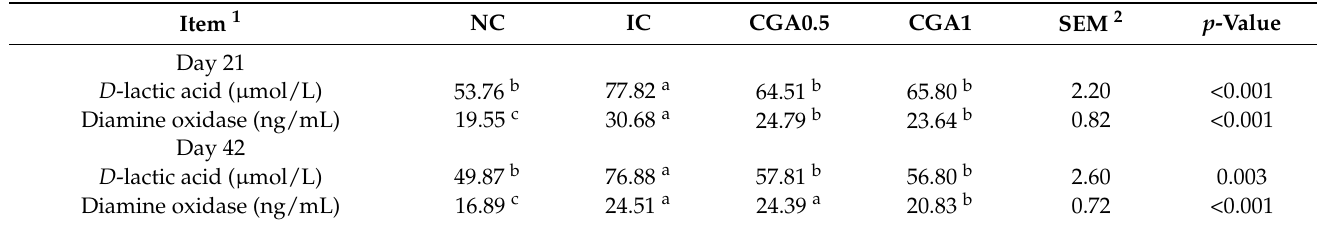
Table 6. Effects of chlorogenic acid (CGA) on serum D -lactate and DAO levels of broilers ( n =